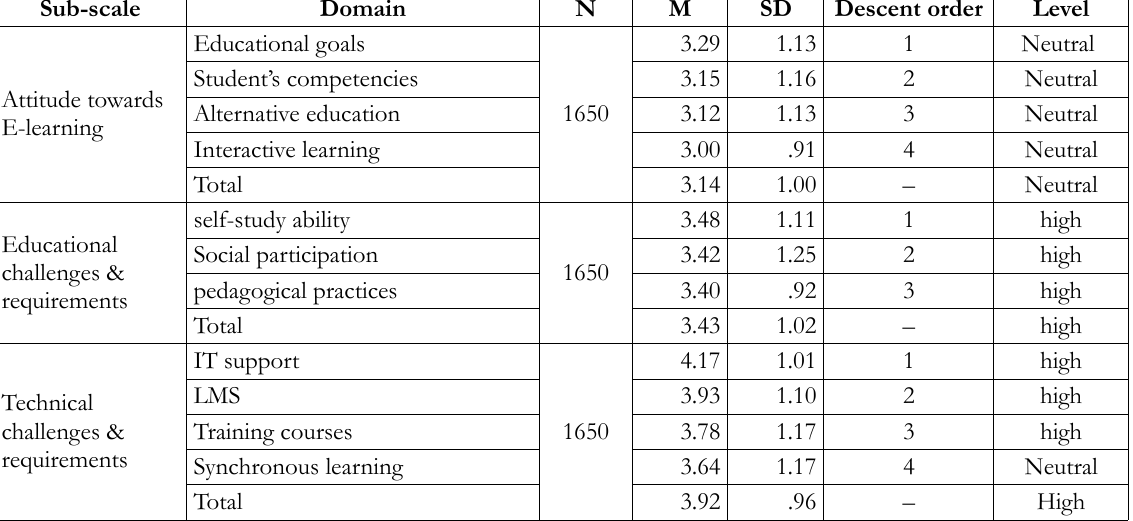
Table 8. Means and stranded deviations of sub-scales and domains